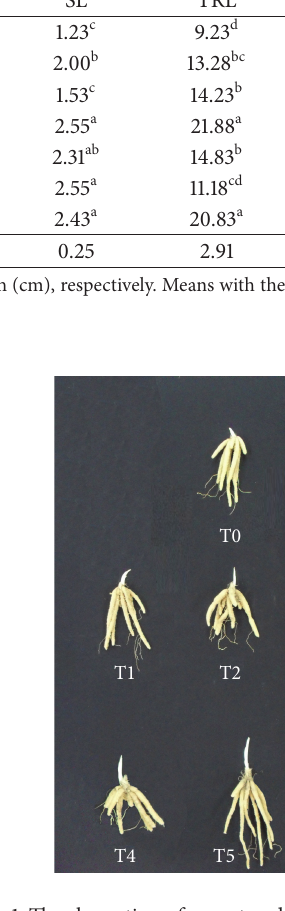
Table 2: Sprout length (cm) and total root length (cm) during early growth as affected by concentration of gibberellic acid (GA acid (HA).